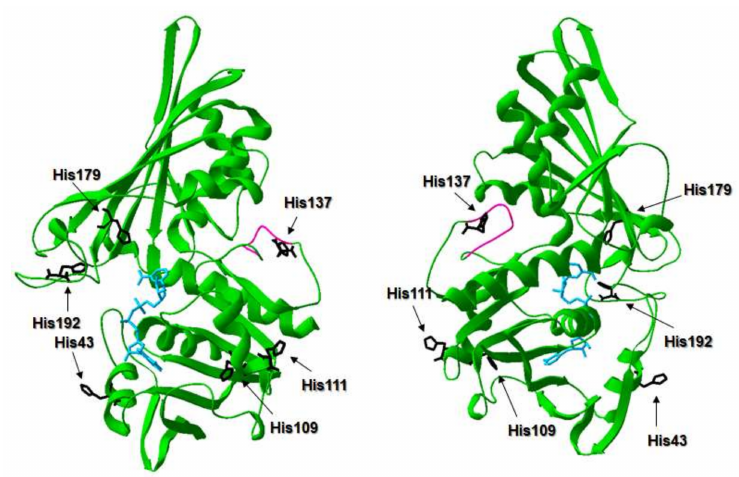
Figure 2. Localization of conserved amino acid residues in the theoretical three-dimensional model of the SgGAPDH protein structure. Potential heme-coordinating histidine residues are shown in black and indicated with arrows, the potential heme-binding regulatory motif is shown in pink, and the NAD molecule is shown in blue. Two orientations of the modeled protein structure are shown.